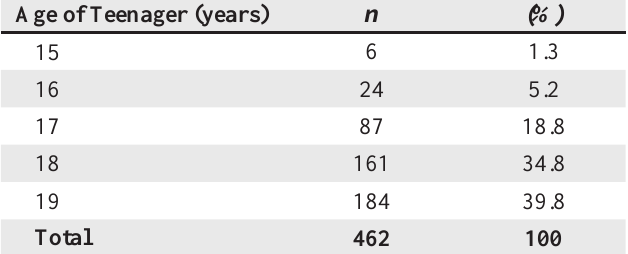
Table 1 : Distribution of adolescent pregnancy according to